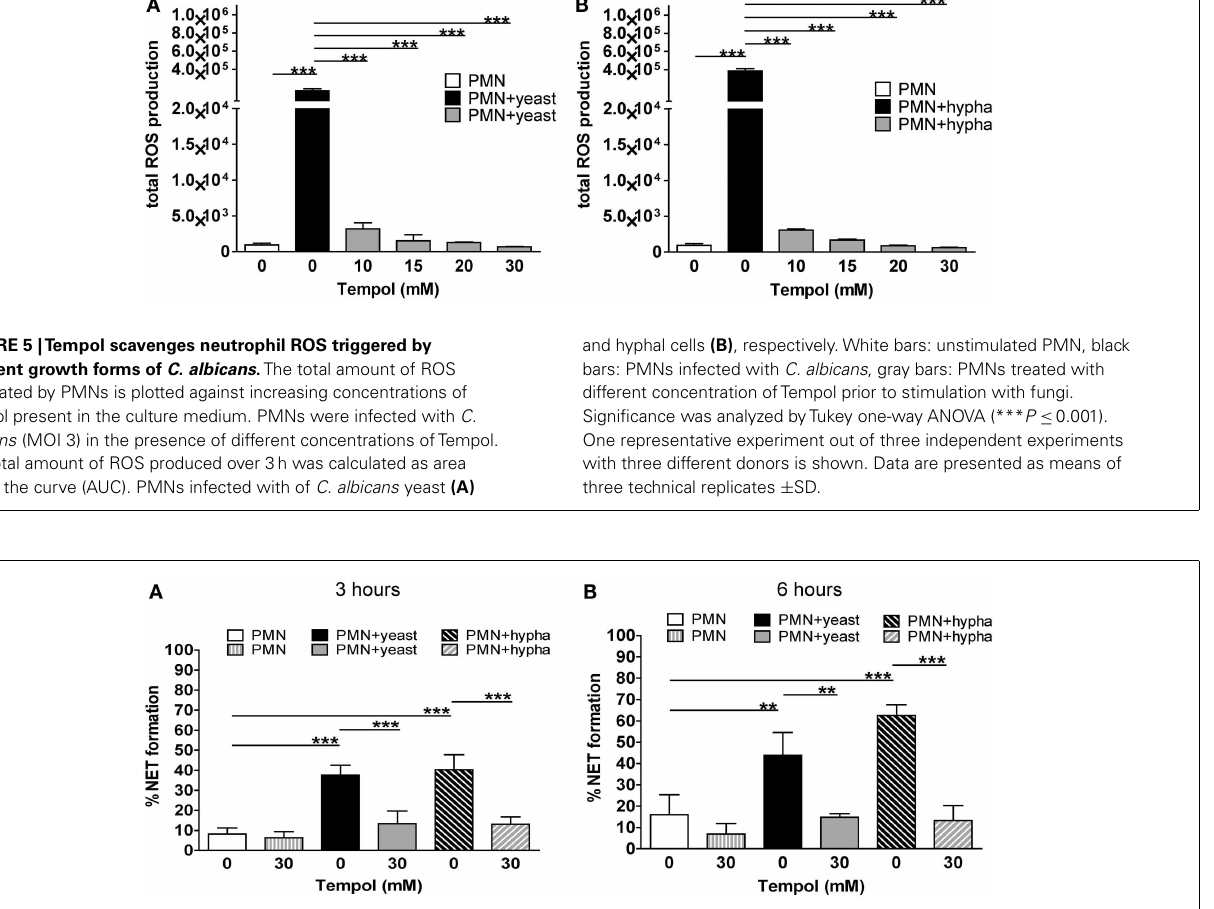
FIGURE 6 |Tempol prevents NET formation induced by different growth forms of C. albicans . Microscopic evaluation of C. albicans infected PMNs (MOI 3) demonstrates reduction of NET formation byTempol. Percentage of NET formation after infection with C. albicans yeast or hyphal cells for 3h (A) and 6h (B) .White bars: unstimulated PMNs, dashed gray bars: PMNs treated withTempol, black bars: PMNs stimulated with C. albicans yeast growth form, gray bars: PMNs treated withTempol prior to infection with